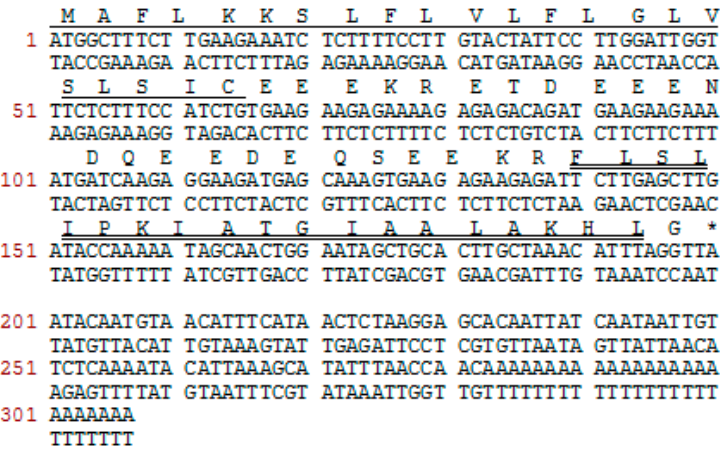
Figure 1. Nucleotide and translated open-reading frame amino acid sequence of biosynthetic precursor cDNA encoding the novel mature peptide. The putative signal peptide is single-underlined, the mature peptide is double-underlined, and the stop codon is indicated by an asterisk.